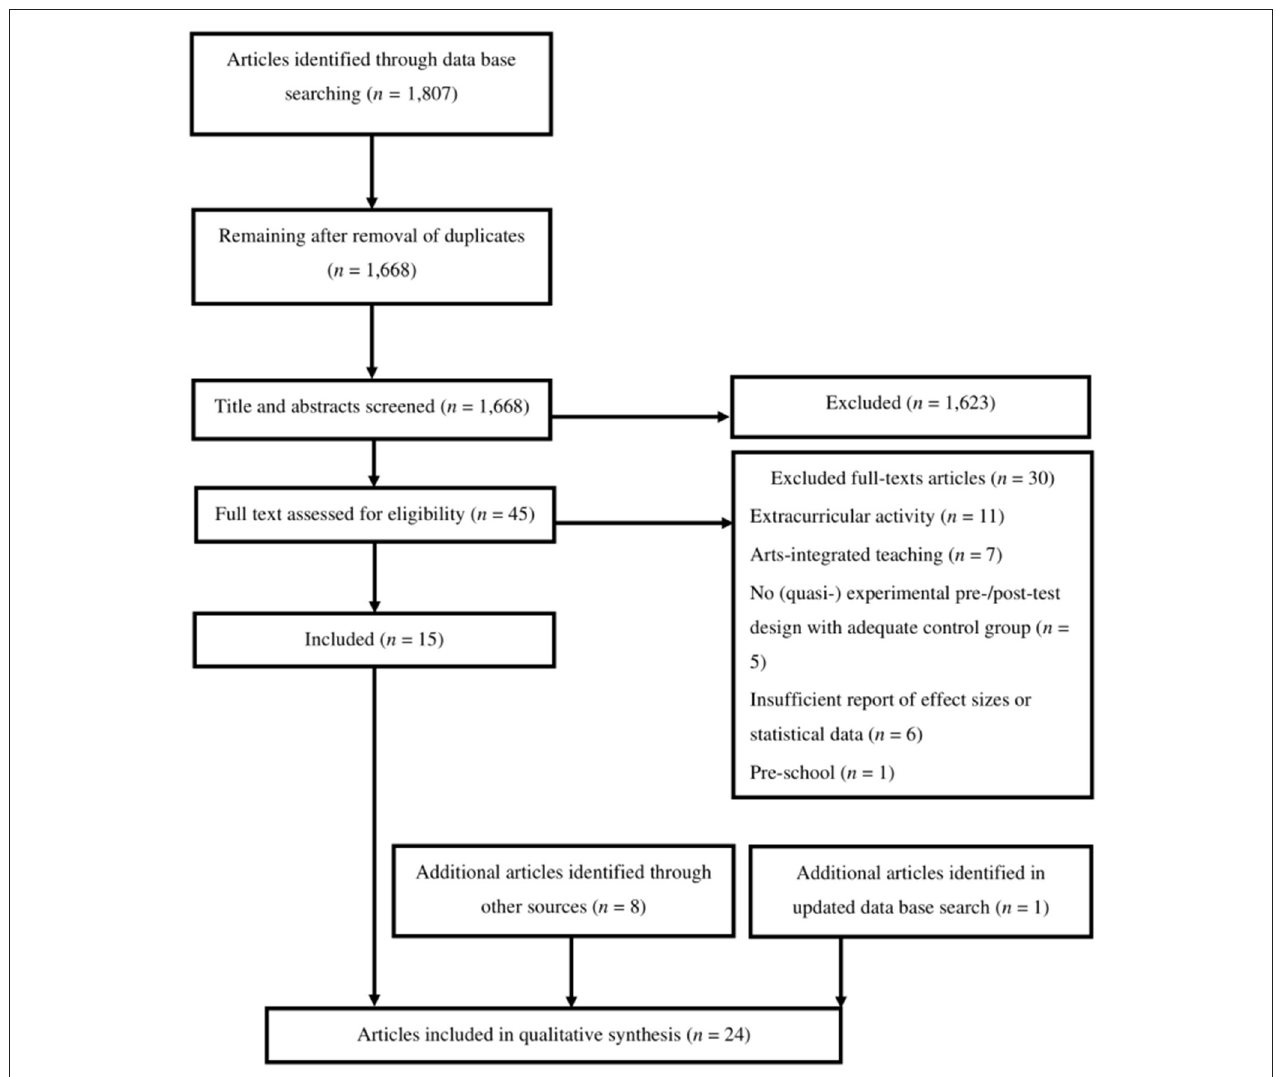
FIGURE 1 | PRISMA flow